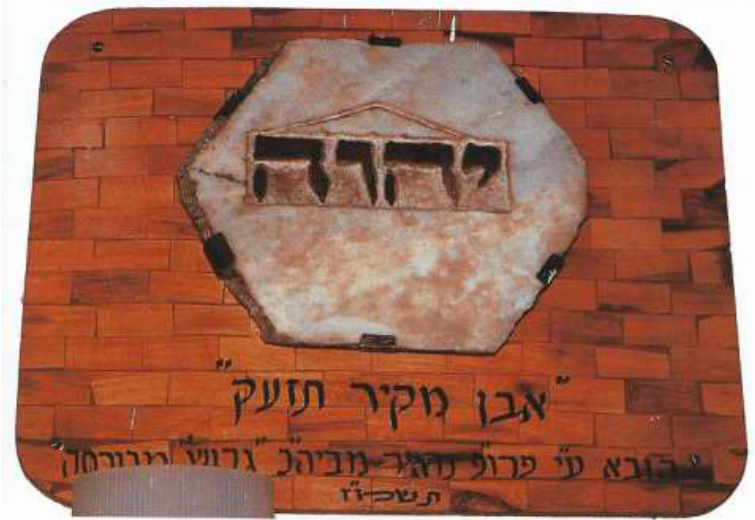
Figure 8. Commemorative marble originally from the Geirush synagogue in Bursa, Turkey, today at the Olei Bursa synagogue, Jerusalem (photo: Baruch Gian,